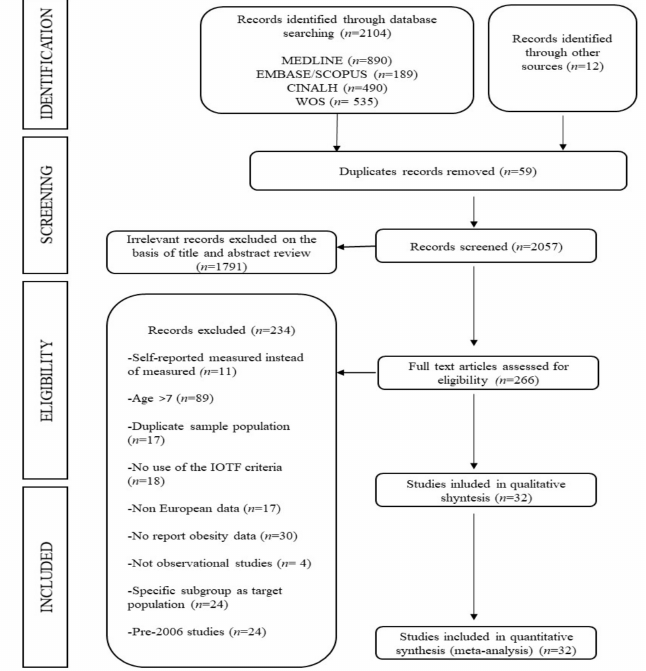
Figure 1. Literature search according to the Preferred Reporting Items for Systematic Reviews and Meta-Analyses (PRISMA) flow chart. Abbreviations: IOTF International Obesity Task Force